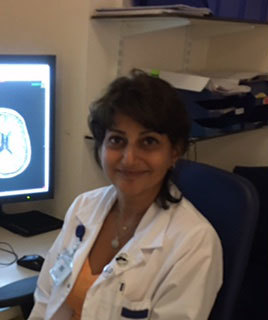
Niloufar Sadeghi